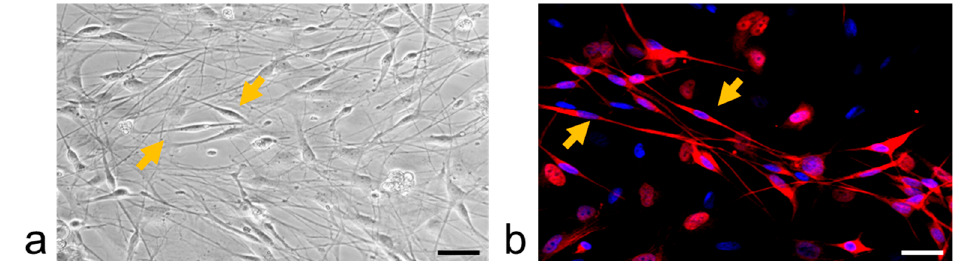
Figure 10. Glial-rich culture, SGCs are identified based on: ( a ) morphology using light microscopy, ( b ) and immunoreactivity as glutamine synthetase (marker of SGC) and DAPI-positive cells using confocal microscopy. Arrow points to the SGCs. Scale bar: 20 μ m.